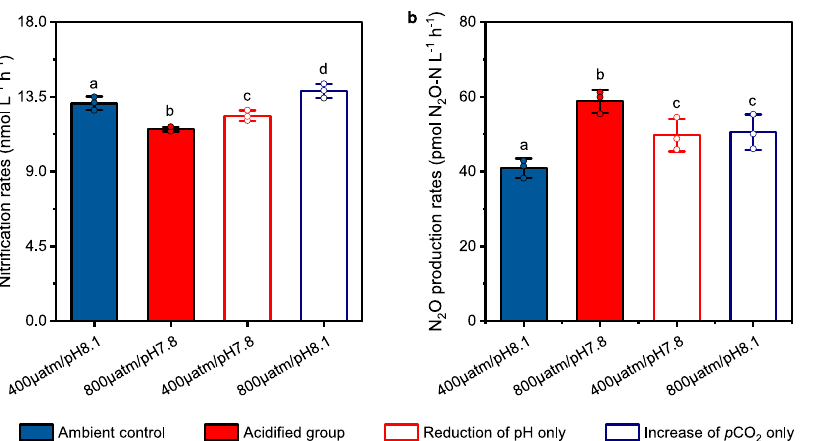
Fig. 3 | Individual effects of increasing p CO 2 and decreasing pH on the activity of nitri fi ers in estuarine and coastal waters. a Nitri fi cation rates. b N 2 O produc- tion rates during nitri fi cation. Four scenarios were constructed: the ambient con- trol (400 μ atm/pH 8.1, blue solid bars), the acidi fi ed group (800 μ atm/pH 7.8, red solidbars),reductionofpHonly(400 μ atm/pH7.8,redopenbars),andincreaseof p CO 2 only (800 μ atm/pH 8.1, blue open bars). Different lowercase letters (a, b, c